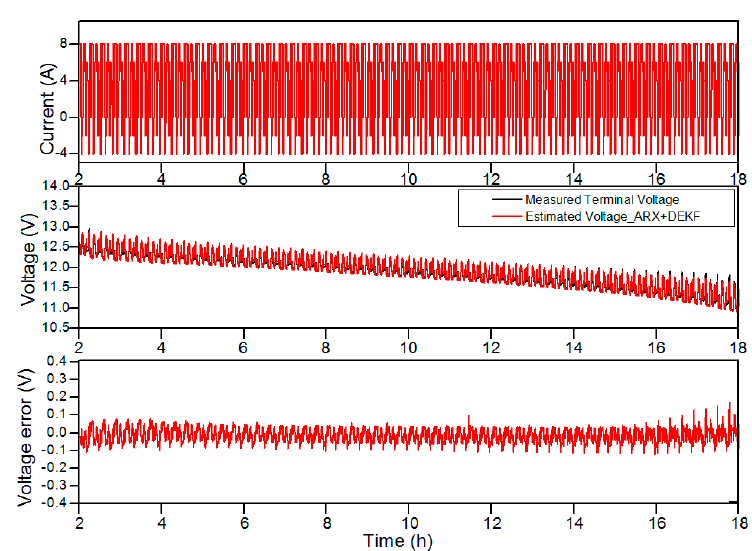
Figure 15. Current profile (upper graph), measured terminal voltage (middle graph) and estimated voltage error (lower graph) at − 5 °C.